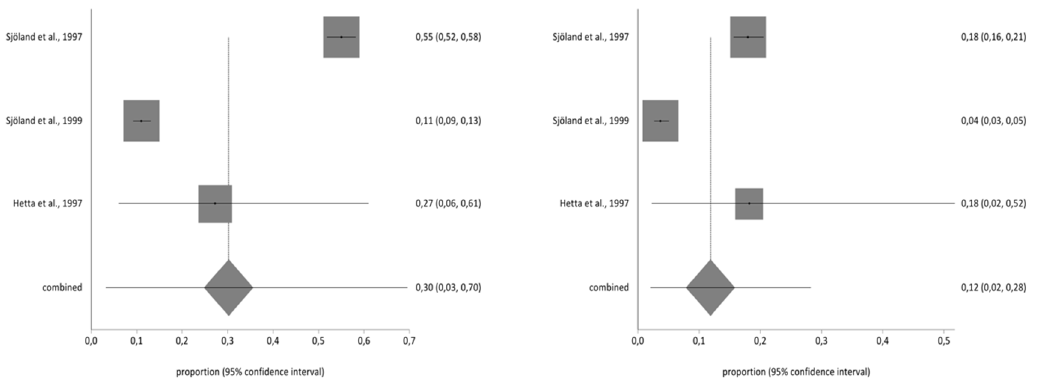
Figure 7. Pre- and post-impact on hobbies.